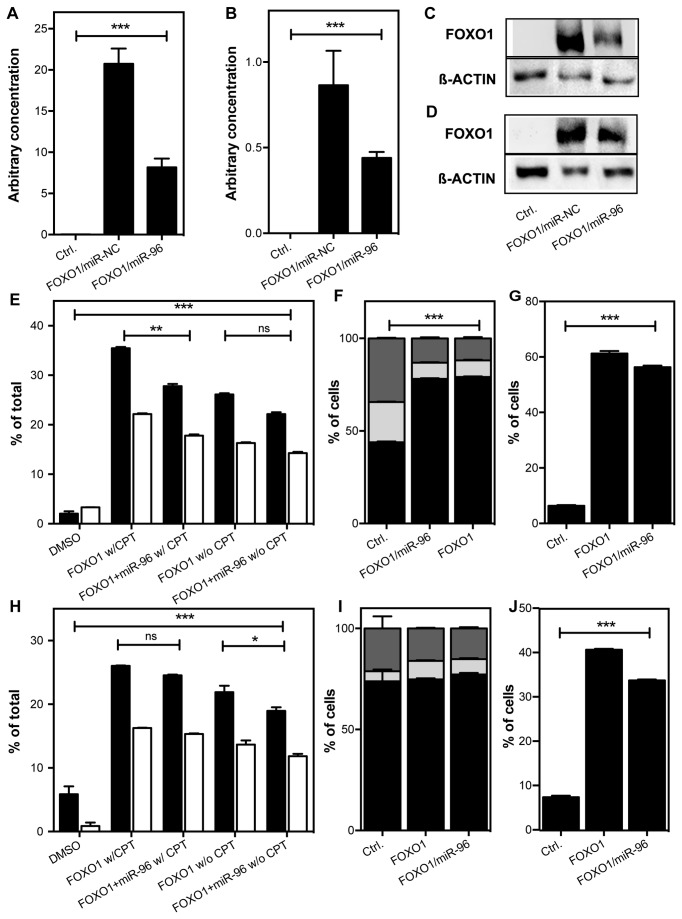
FOXO1 overexpression in prostate cancer cell lines.LNCaP and DU145 cells were transfected with 500 ng FOXO1 full length clone or empty vector, 10 nM pre-miR-96 or pre-miR-NC #1. FOXO1 expression in (A) LNCaP and (B) DU145 cells. Data are shown as mean (+SD) of three independent assays. *** P <0.001, One-way ANOVA. FOXO1 protein expression in (C) LNCaP and (D) DU145 cells was visualized by western blotting. β-Actin was used as a loading control. Apoptosis in CPT-treated (E) LNCaP and (H) DU145 cells. 24 h after transfection cells were treated with 10 µM CPT for 24 h. Cells were stained with Annexin V-FITC and PI. Fraction of early (black bars) and late (white bars) apoptotic cells was measured by flow cytometry. Data are shown as mean (+SD) of three independent assays. ns, P>0.05,*P <0.05,**P<0.01,***P<0.001, Two-way ANOVA, Bonferroni’s post test). Cell cycle transition was measured by PI staining in transfected (F) LNCaP and (I) DU145 cells. Cells were serum starved one day after transfection for another 24 hrs and subsequently fixed and stained. Black, G1-phase; light grey, S-phase; dark grey, G2/M-phase. Data are shown as mean of three independent assays. ***P<0.001, One-way ANOVA. Analysis of subG1 peak in (G) LNCaP and (J) DU145 cells. Data are shown as mean of three independent assays. ***P<0.001, One-way ANOVA.